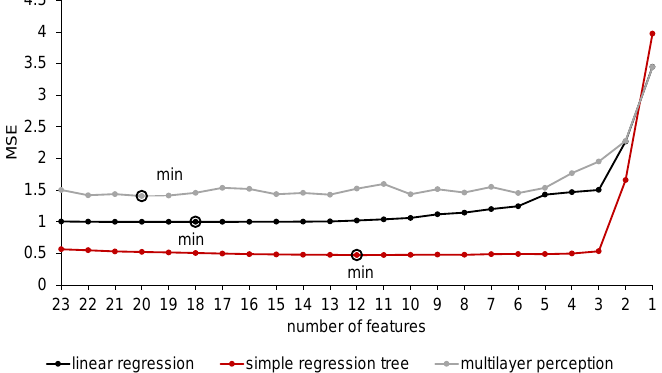
Figure 12. Mean squared errors (MSE) from feature selection for linear regression (LR), simple regression tree (SRT) and multilayer perception (MLP) predicting the electric power demand.